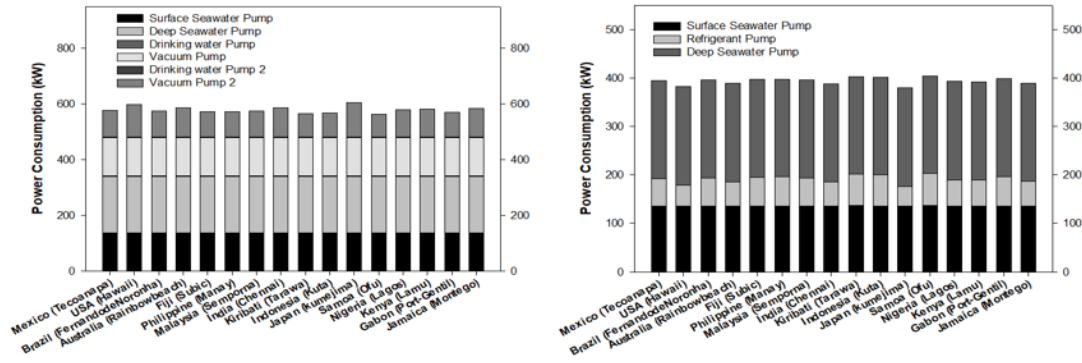
Figure 6. Power consumption of OC-OTEC ( left ) and CC-OTEC ( right ).